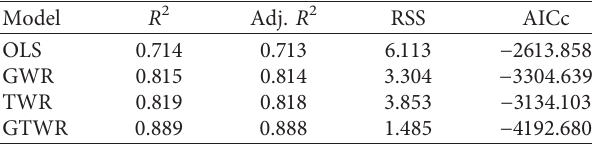
Table 2: Comparison of the model test results.